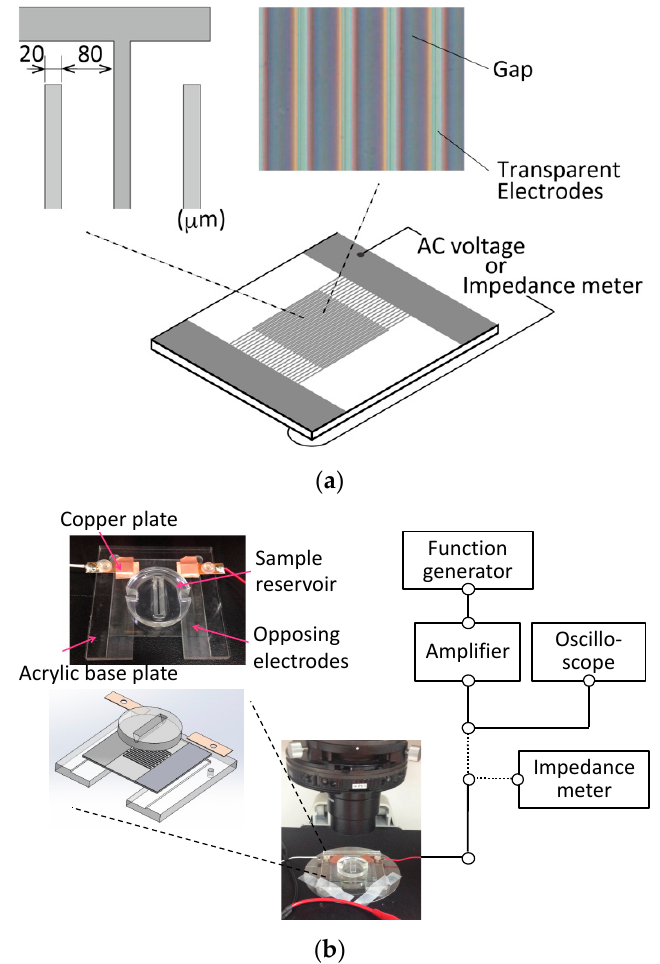
Figure 2. Experimental set-up for the electrical impedance measurement of a cell suspension. ( a ) Geometry of opposing comb-shaped electrodes: The width of each electrode line was 20 μ m and the distance to the adjacent electrode was 80 μ m. ( b ) Wiring diagram for the dielectrophoresis and impedance measurement system.